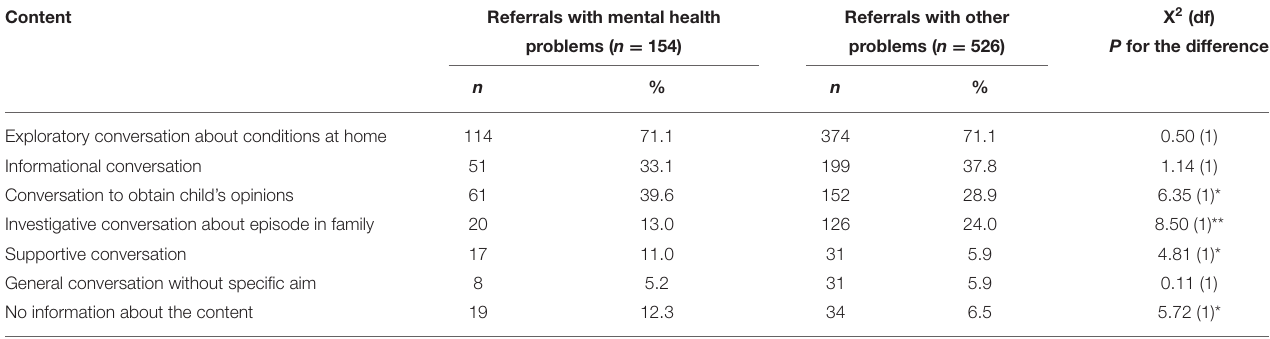
TABLE 3 | Differences in content of CWPS conversations with children ( N =